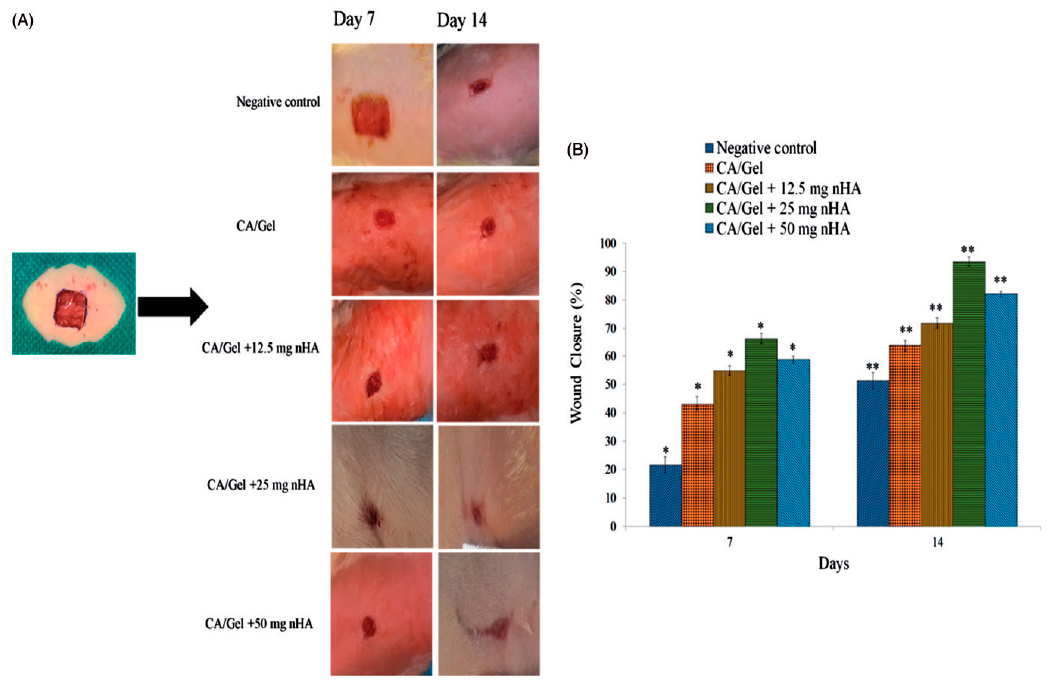
Figure 10. Cosmetic appearance of the wounds treated with the cellulose acetate/gelatin/nano- hydroxapatite dressings 7 and 14 days post-wounding ( A ) and histograms comparing the wound closure percentages at the end of the 7th and 14th day post-wounding ( B ) (reproduced with permission from Ref .